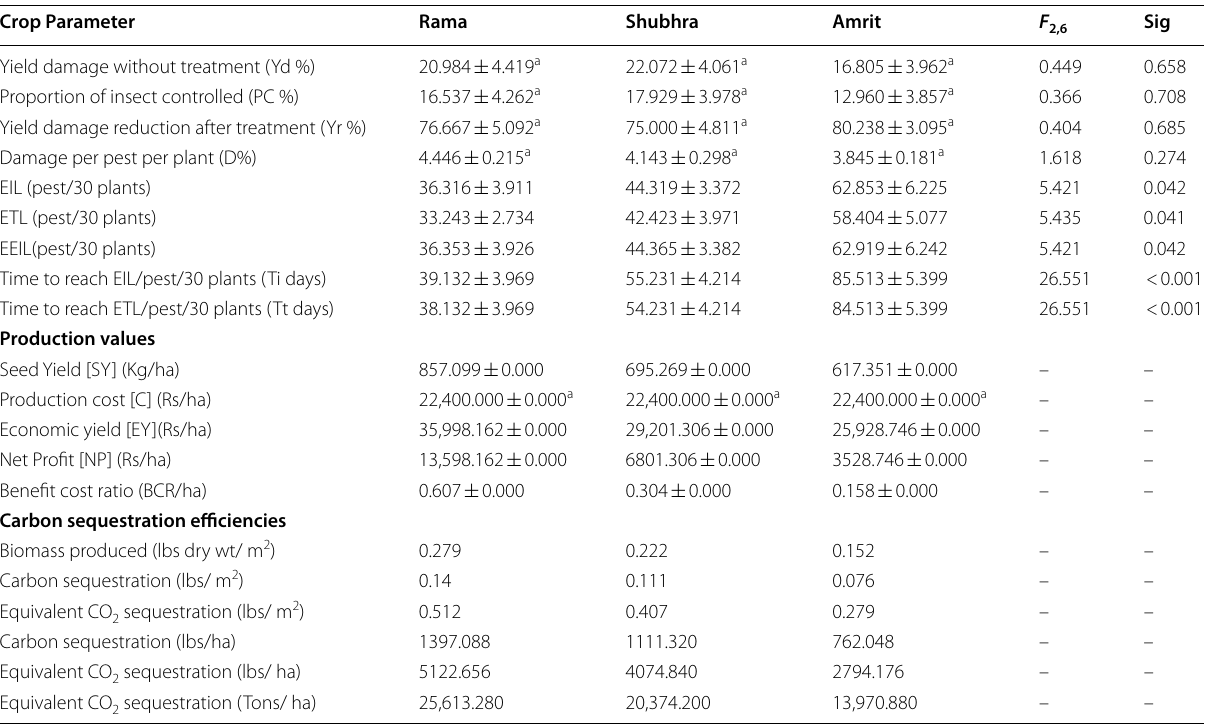
Table 7 Yield loss and ET values along with crop production values (Mean selected sesame ( S. indicum ) cultivars (Rama, Shubhra and Amrit) observed over a traditional synthetic pesticide (Triazophos 40 EC) along with control (without pesticide) side by side having plant density of 30